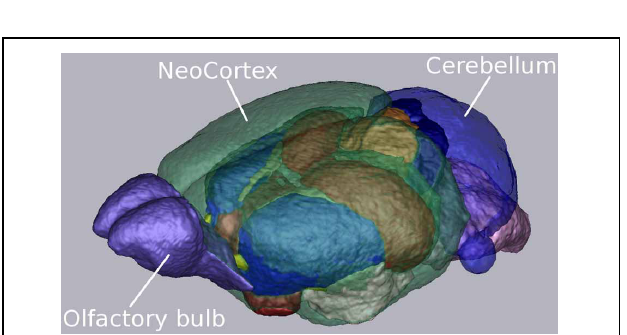
FIGURE 10 | 3D rendering of the population average segmentation. Cerebellum, neocortex, corpus callosum and external capsule were made partially see-through to allow better visualization of the inside regions.